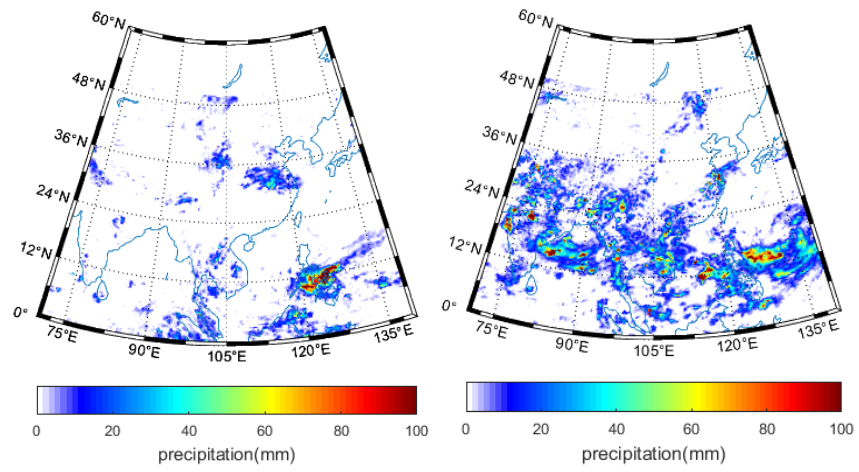
Figure 5. TRMM precipitation over China on 15 April ( left ) and 27 July ( right ) 2014.